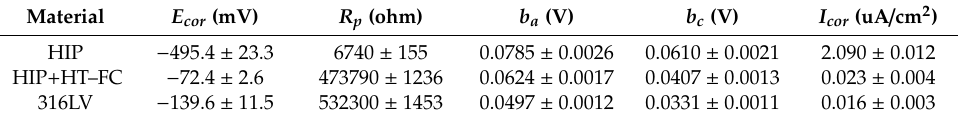
Figure 13. Potentiodynamic polarization curves of the tested specimens in Hank’s solution. Table 7. The main parameters of corrosion process of HIPped